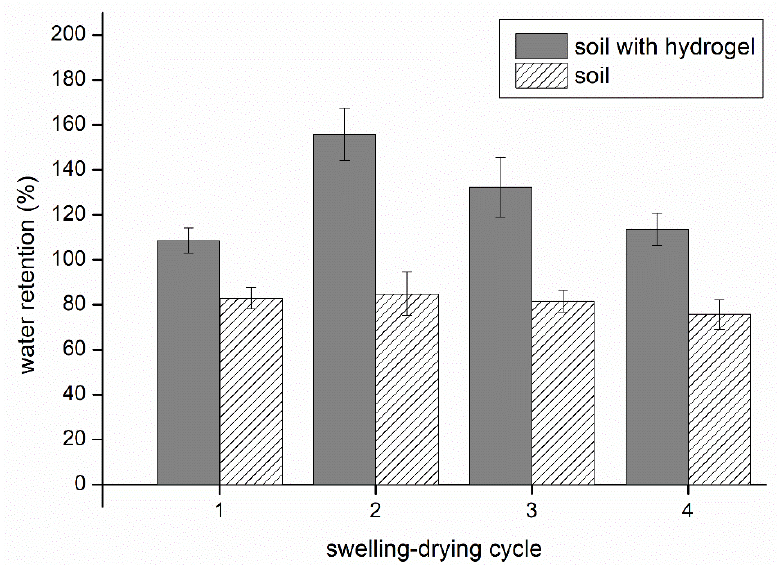
Figure 8. Water retention and re-absorption of hydrogel H5CA in soil during four swelling–drying cycles.